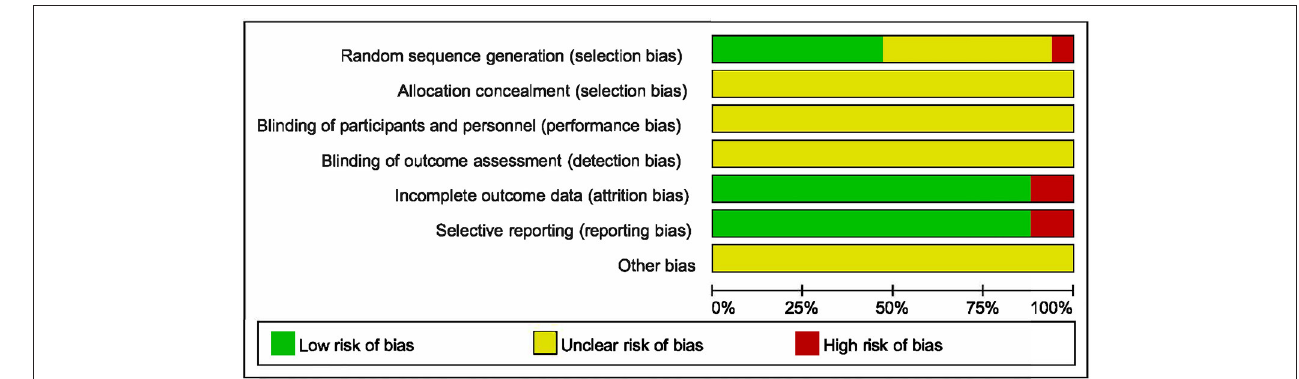
FIGURE 2 | Risk of bias graph.